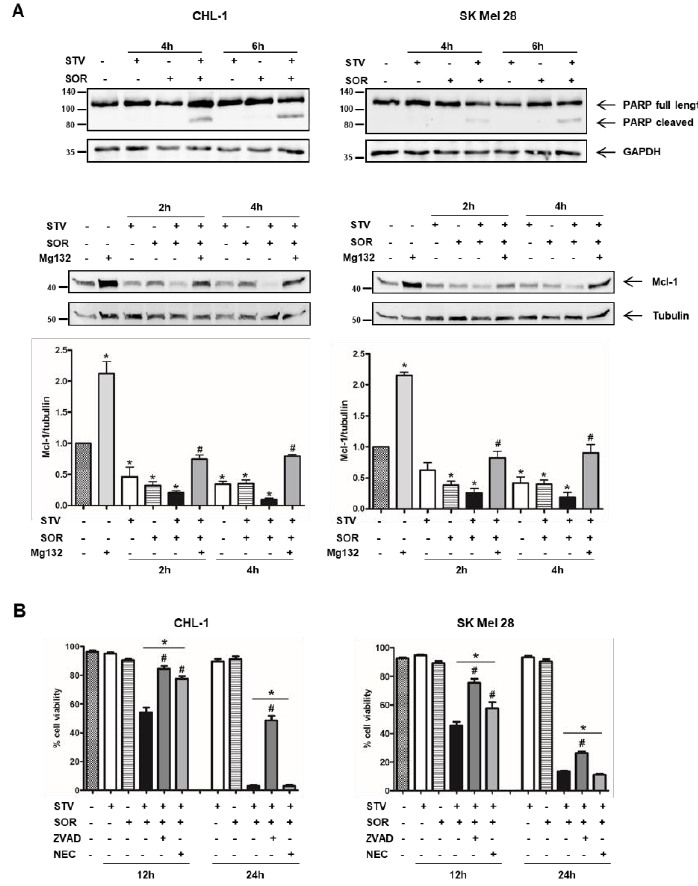
Figure 2. Cell death elicited by SOR + STV on melanoma cells has apoptotic features. ( A ) Representative immunoblots of PARP cleavage and Mcl-1 degradation (apoptotic markers) analyzed by western blotting in CHL-1 and SK Mel 28 cells untreated or treated as indicated. GAPDH or tubulin were used as loading controls. (Histograms represent mean ± SD) * p < 0.0001 compared to untreated cells; # p < 0.0001 compared to Mg132 absence. One-way ANOVA, Bonferroni post-test. ( B ) Cell viability was also evaluated in both cell lines after 12 or 24 h of STV, SOR, SOR + STV, Z-VAD-FMK, or necrostatin-1 (NEC), as indicated. (Histograms represent mean ± SD) * p < 0.0001 compared to control cells. # p < 0.0001 compared to SOR + STV. One-way ANOVA, Bonferroni post-test.